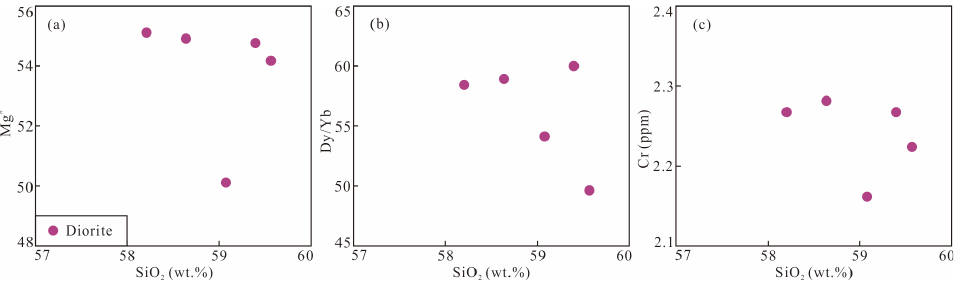
Figure 12. Diagrams of ( a ) La versus La/Sm, ( b ) La versus La/Yb ( c ) and Th versus Th/Yb of the mafic–ultramafic rocks and diorites, showing the partial melting evolution trend (modified after [103]).